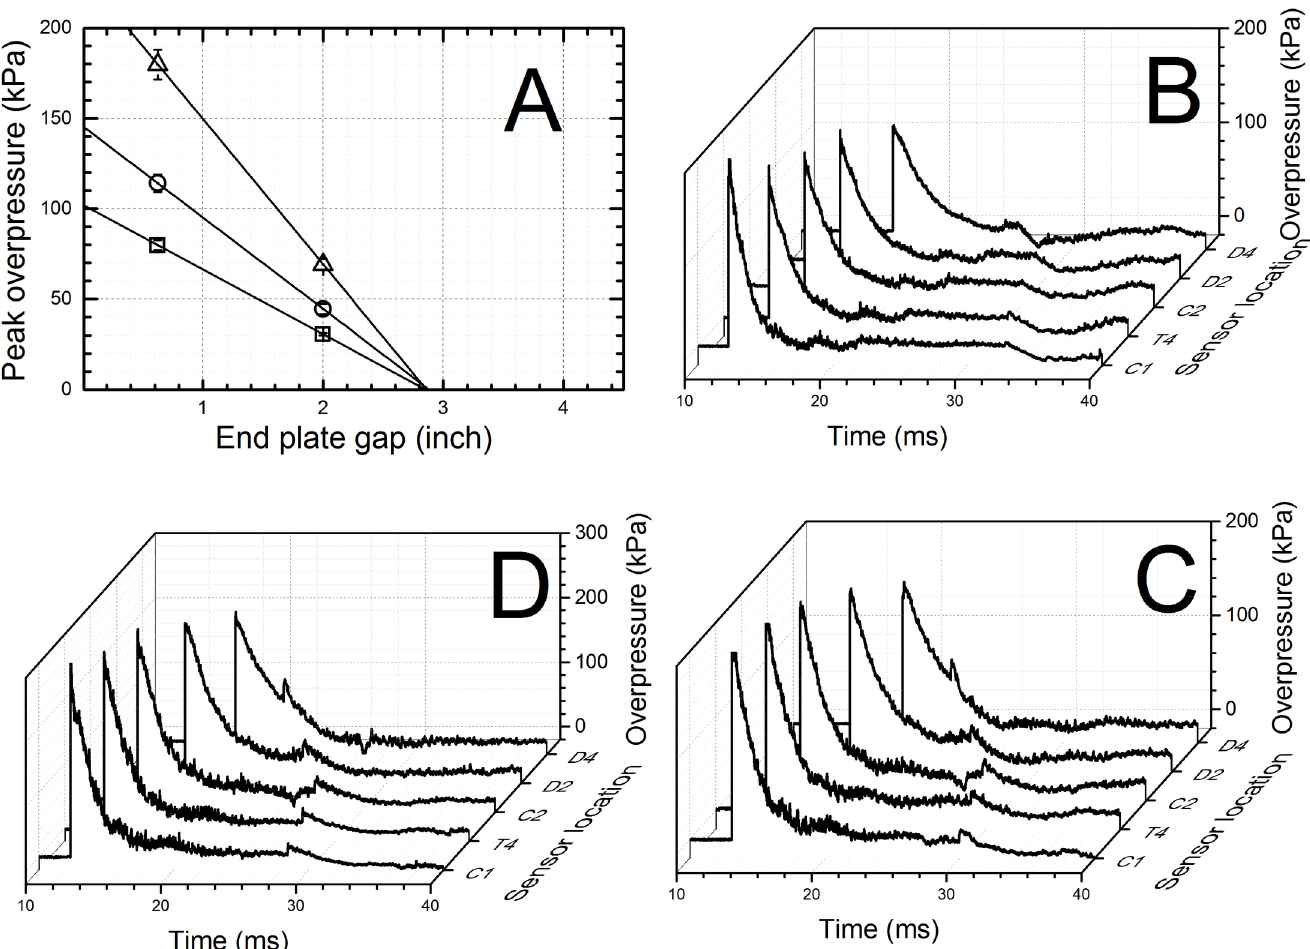
Fig 7. The optimization of the end plate to the shock tube gap distance. A. Reflected peak overpressure values measured at the D4 location for three different membrane thicknesses (0.02, 0.04 and 0.06 inch) and two different end plate gap sizes (0.625 and 2.0 inches) were used to identify the optimal gap size, i.e. the point on the plot where all linear functions converge ( x 0 = 2.85 inch). Overpressure profiles recorded using optimized end plate position at three different blast intensities generated using: B. 0.02 ” , C. 0.04 ” and D. 0.06 ”